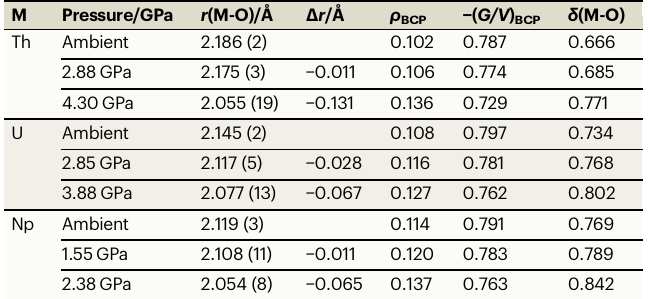
Table 1 | Metal-oxygen distances r (M-O) (in Å) and QTAIM metrics (in atomic units (a.u.)) for M(OAr) 4 (M = Th, U, Np) as a function of